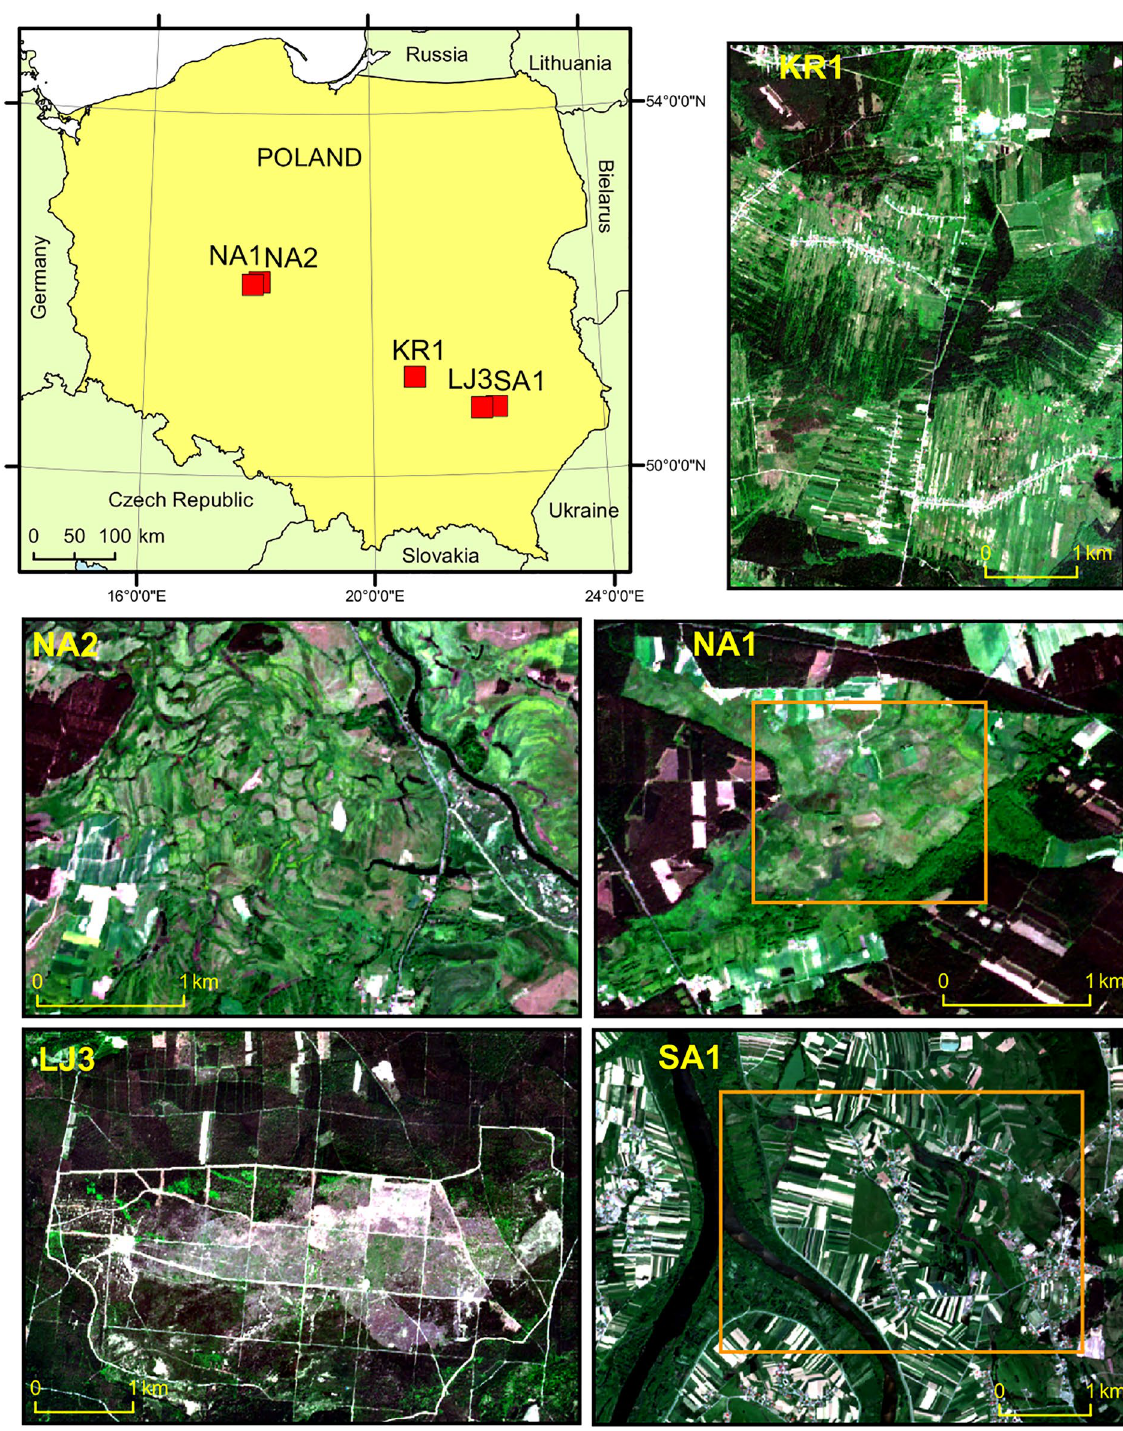
Figure 2. Study sites: KR1—PLH260001 Dolina Krasnej and PLH260012 Uroczysko Pięty; NA1 and NA2— PLH300009 Ostoja Nadwarciańska; LJ3—PLH060031 Uroczyska Lasów Janowskich; SA1—PLH180020 Dolina Dolnego Sanu. Orange squares highlight the areas presented as maps in the results section, background images are Sentinel-2 RGB compositions. Figure created by the authors using ArcMap 10.6.1 software (https:// suppo rt. esri. com/ en/ Produ cts/ Deskt op/ arcgis- deskt op/